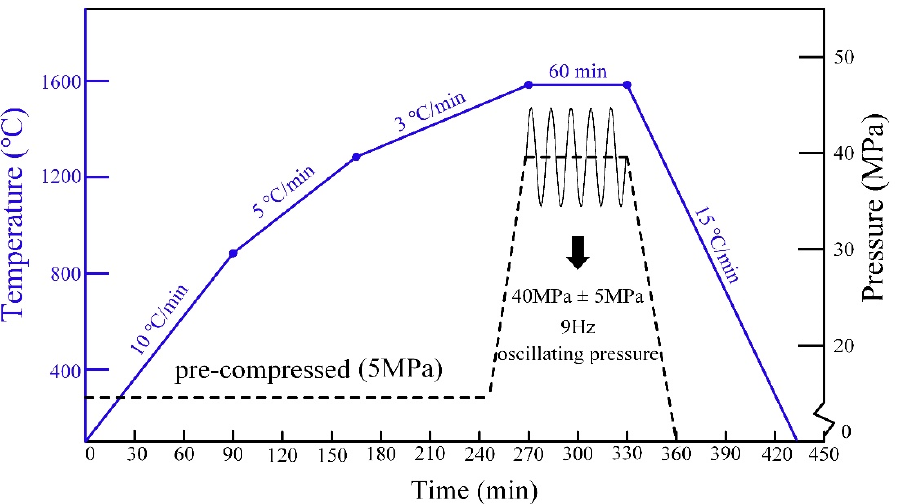
Figure 1. Schematic diagram of sintering mechanism in this study [19]. “Reproduced with permission from Guo Zhenping, Journal of Alloys and Compounds; published by Elsevier, [2021]”.